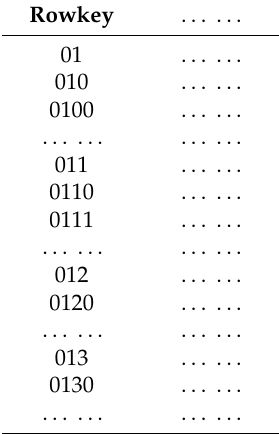
Table 2. Store schema of the hierarchical Hilbert code as the rowkey. Rowkey